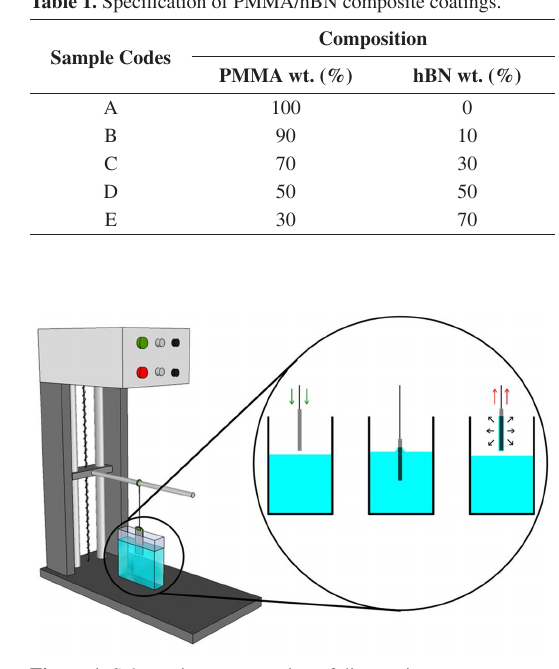
Figure 1. Schematic representation of dip-coating